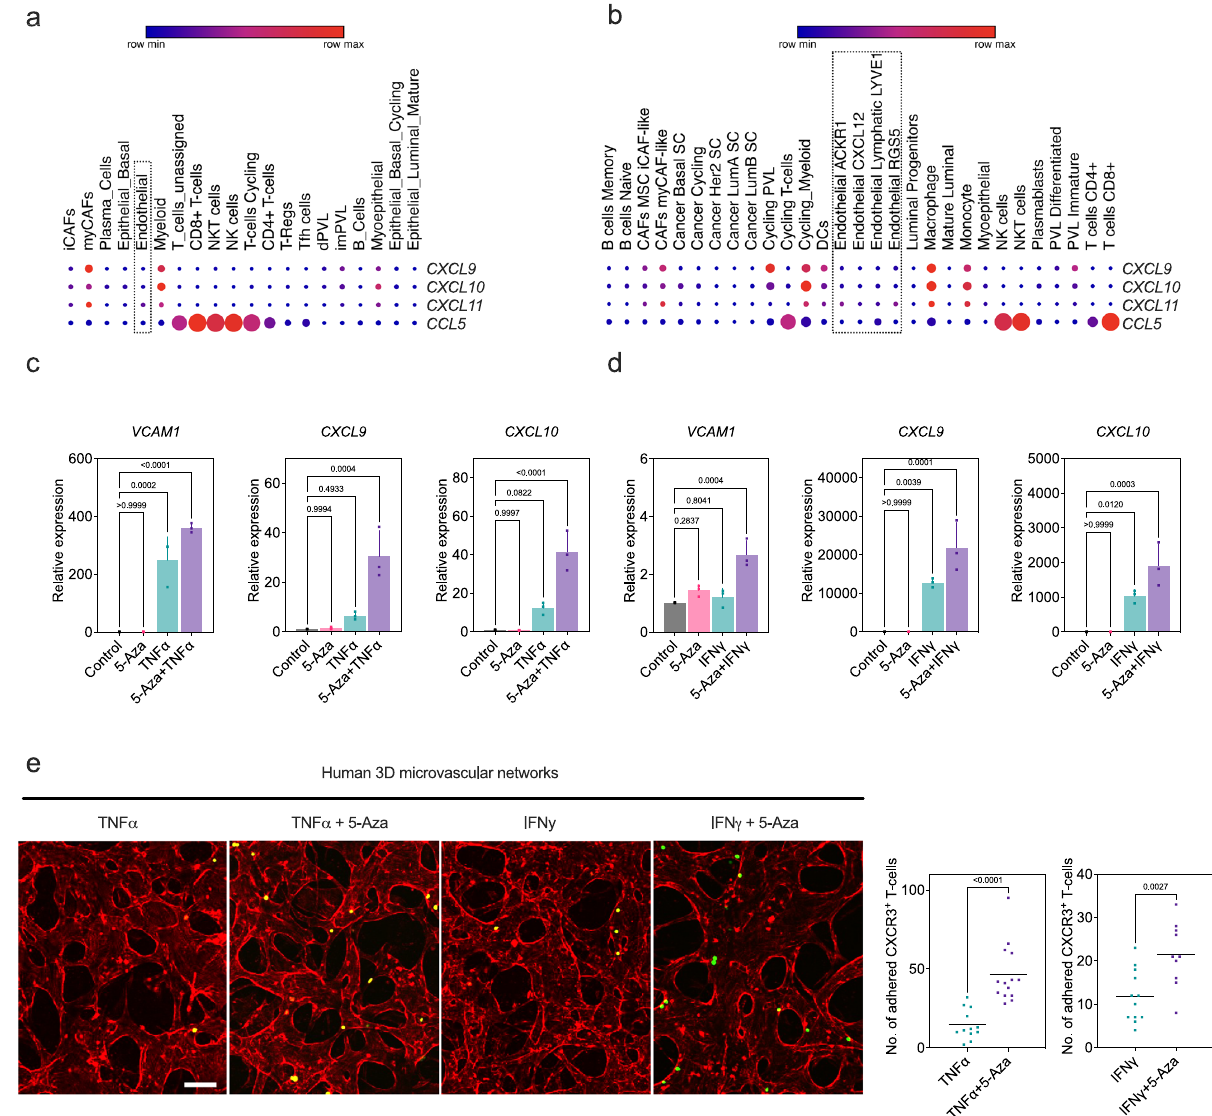
Fig. 6 | Targeting DNMT1 augments the adhesion of CXCR3-expressing T-cells to human 3D vascular networks under fl ow. a Examination of the indicated chemokine by cell type using human scRNAseq data from breast cancer. b ExaminationoftheindicatedchemokinebycelltypeusinghumanscRNAseqdata frombreastcancer.Datafroma-bwerepreviouslygenerated 44,45 . c qPCRanalysisof the indicated target gene in human ECs (HUVEC) primed with 5-Aza prior to TNF α challenge ( n = 3 biological replicates assayed in triplicate). Results were analyzed using ANOVA followed by Dunnett ’ s multiple comparisons test. d Same is in “ c ”